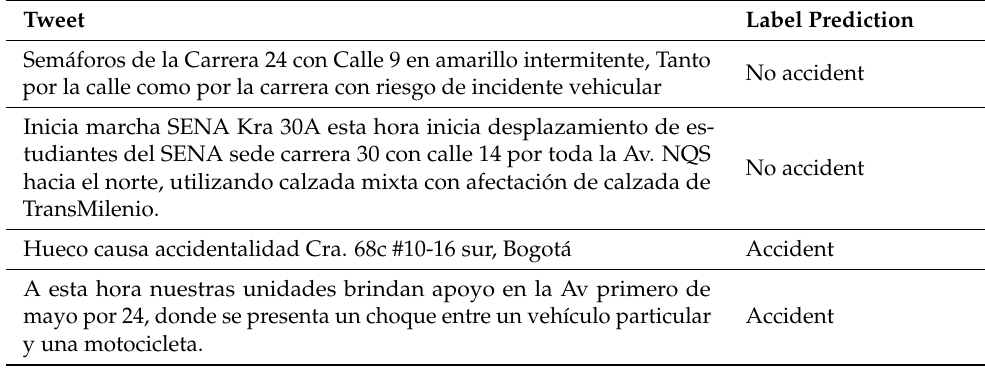
Table 14. Correct accuracy analysis.